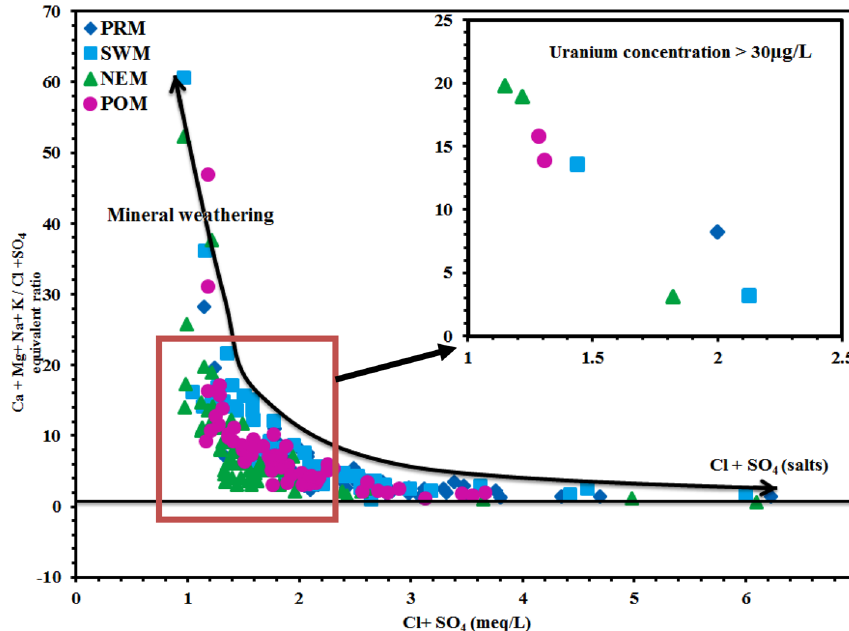
Fig. 11 Bivariate plot of Cl + SO 4 with Ca + Mg + Na + K/Cl + SO